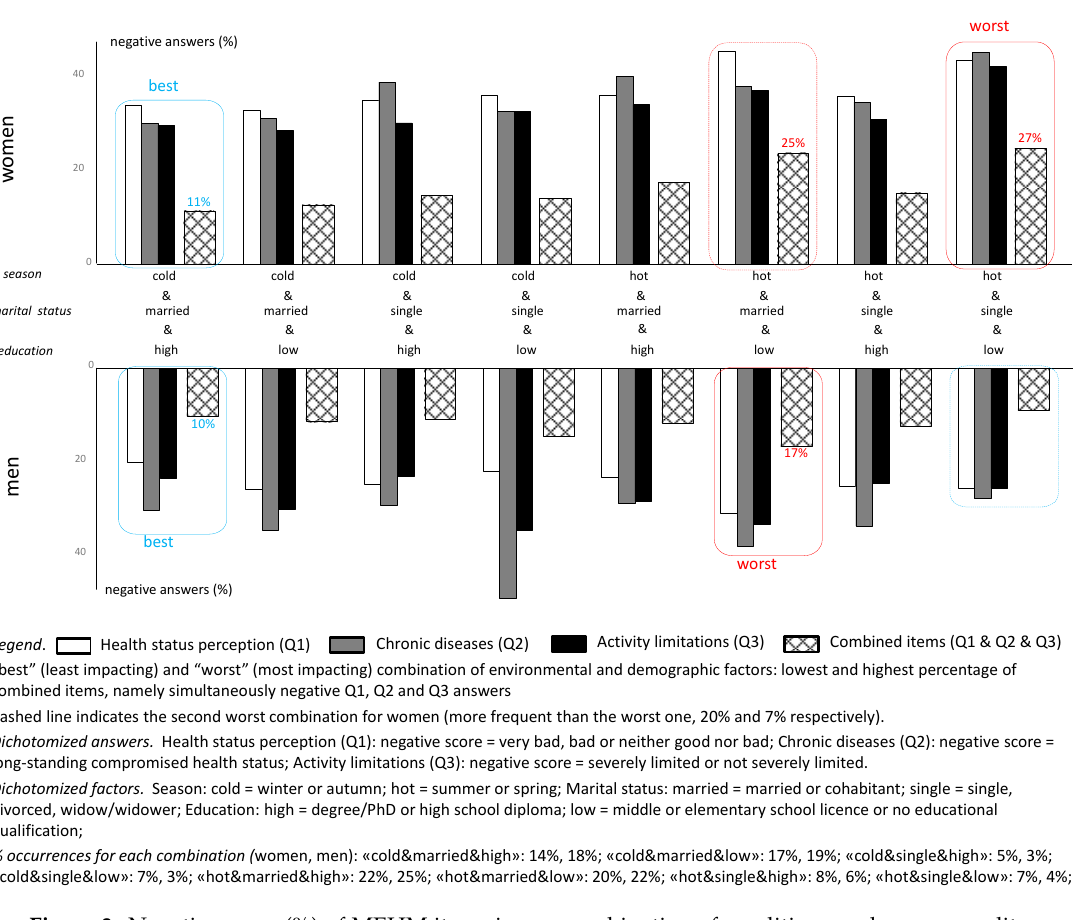
Figure 3. Negative score (%) of MEHM items in any combination of conditions such as seasonality (cold / hot), marital status (married / single) and level of education (high / low), distinguishing between men and women. Plots are referred to dichotomized variables (data source: the CUORE Project Health Examination Survey 2008–2012, Italian men and women, 35–79 years old). Combinations of factors were identified as worst or best on the basis of the percentage—highest and lowest, respectively—of participants who, for each specific combination of factors, gave simultaneous negative answers to all MEHM items.